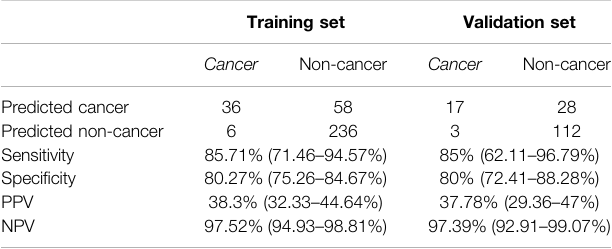
TABLE 1 | The performances of MTOP5Zscores in the identi fi cation of maternal cancer in the training and validation sets. Training